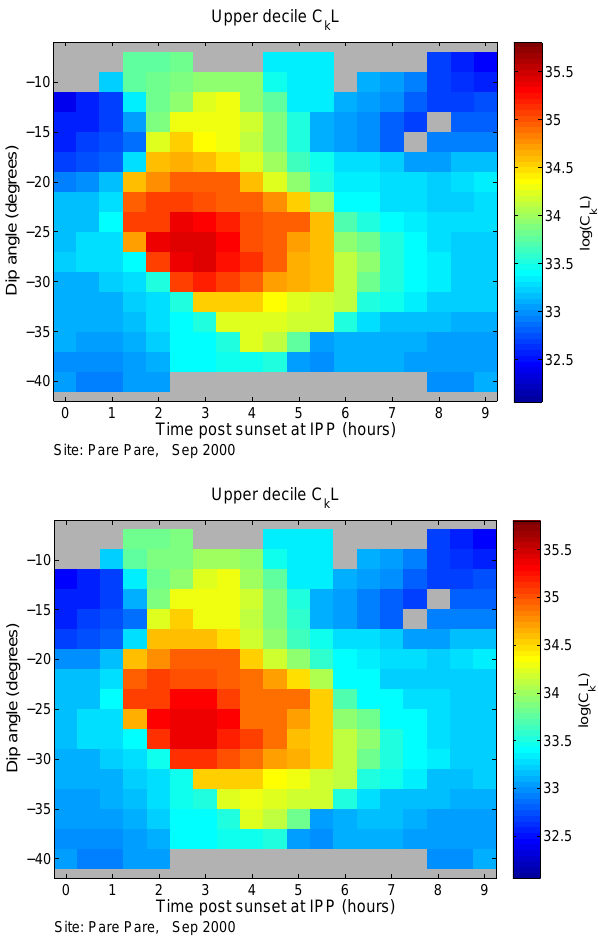
Fig. 4. Upper decile C k L , September 2000, at Pare Pare. The top panel displays results using p calculated from Eq. (3) while the bottom panel a fixed value for p of